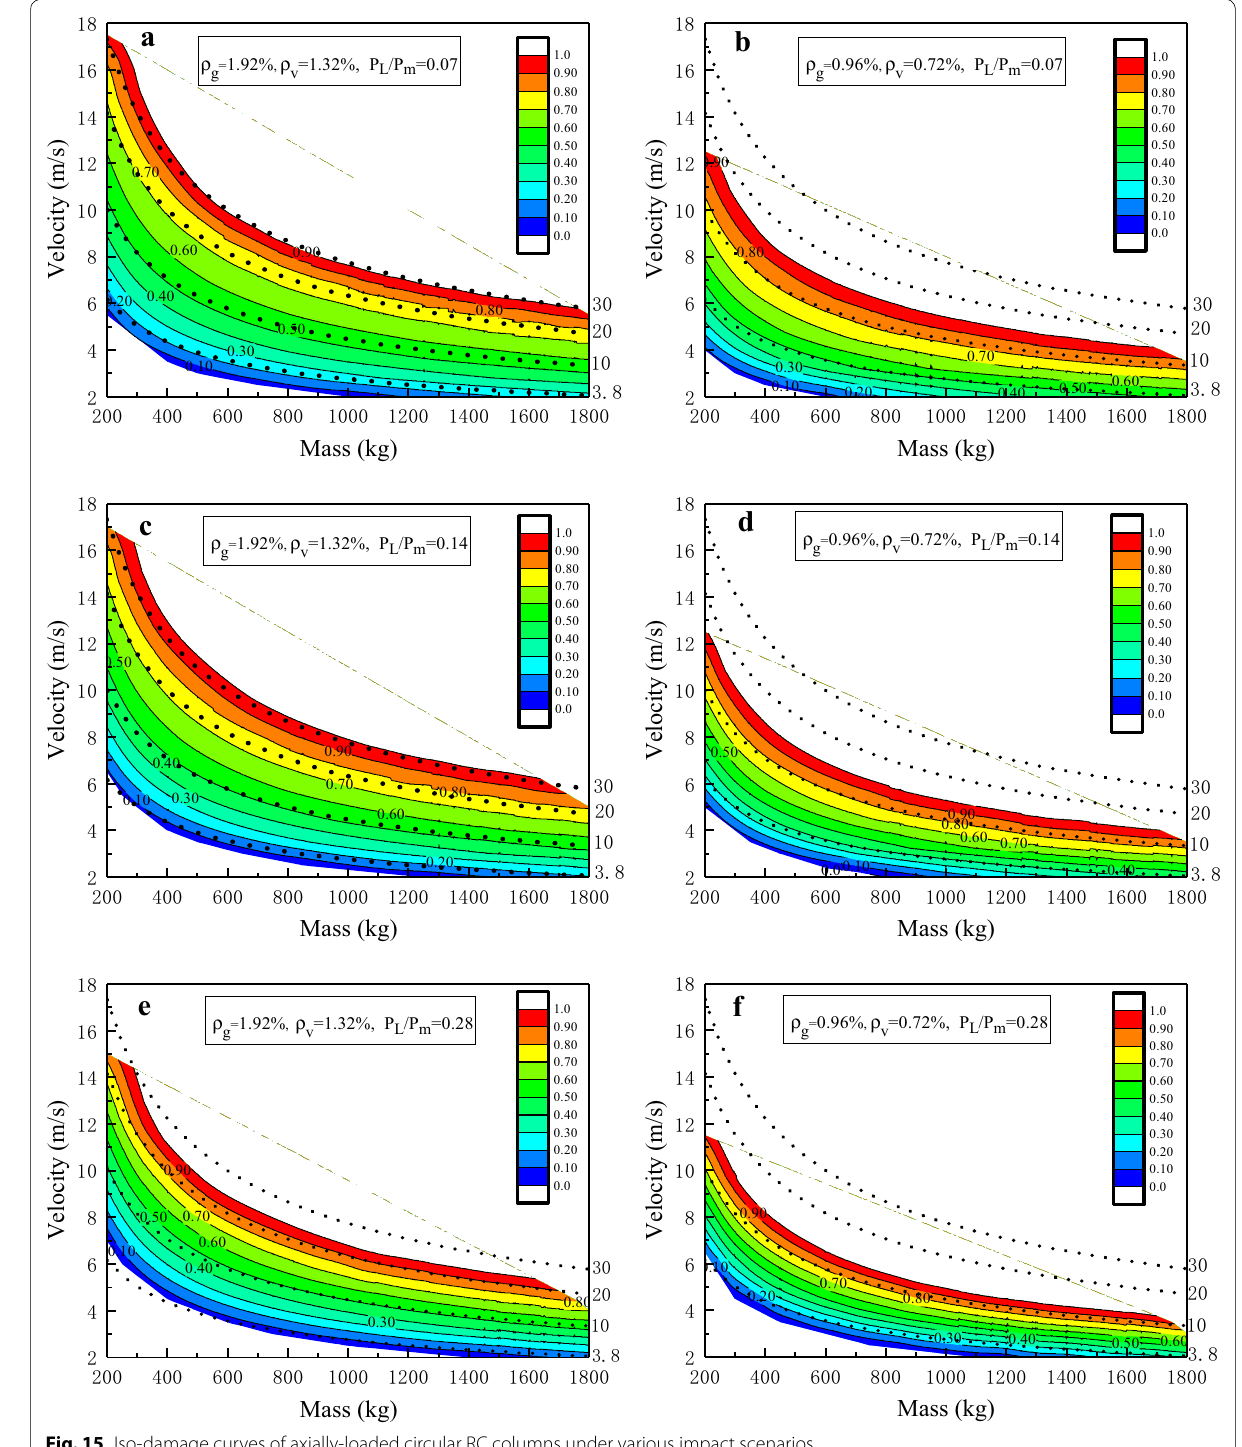
Fig. 15 Iso-damage curves of axially-loaded circular RC columns under various impact